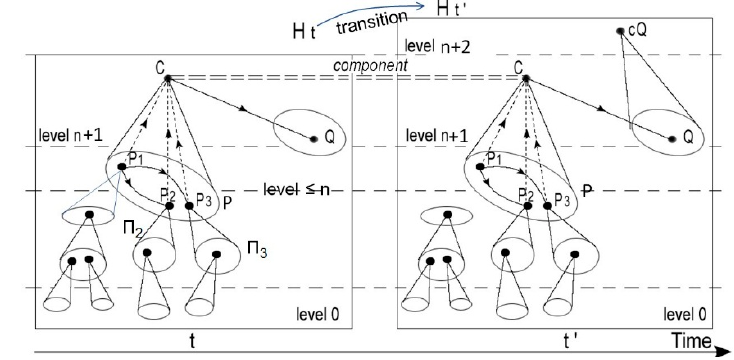
Figure 5. Two configurations H t and H t' of a HES and the transition from t to t'.